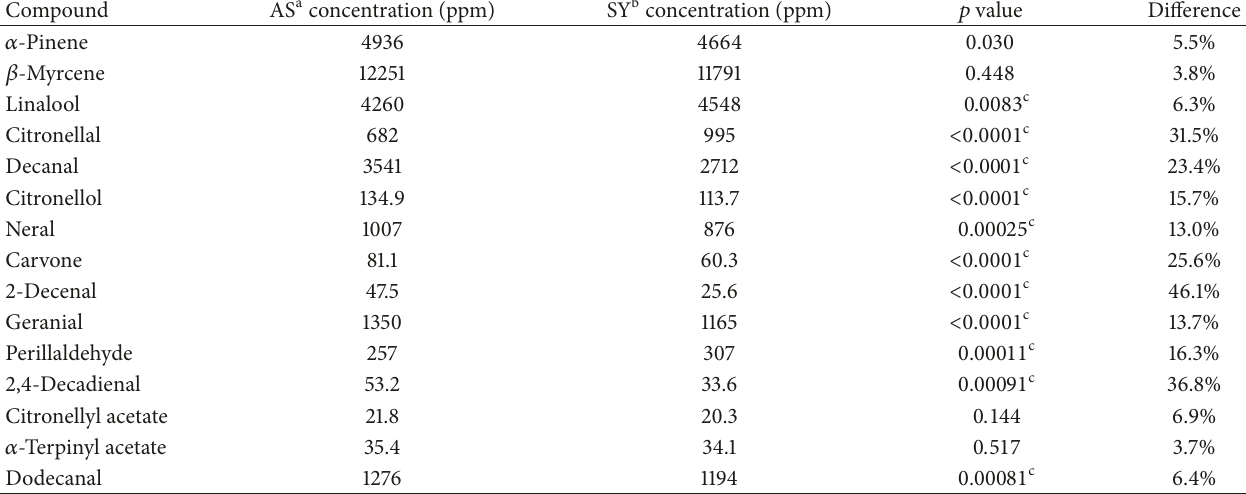
Table 6: Valencia late asymptomatic versus symptomatic compound concentration.